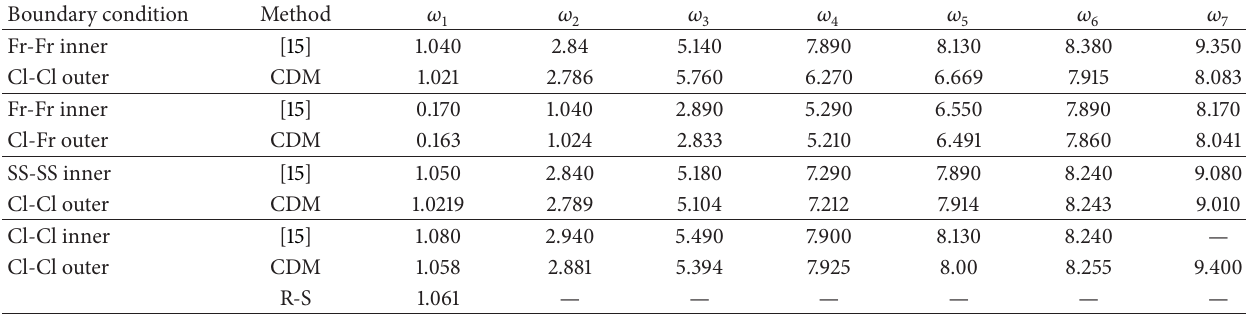
Table 9: First free frequencies of vibrations of DWCNTs with different boundary conditions between inner and outer tubes, (for 𝜂 = 0 ). Boundary condition